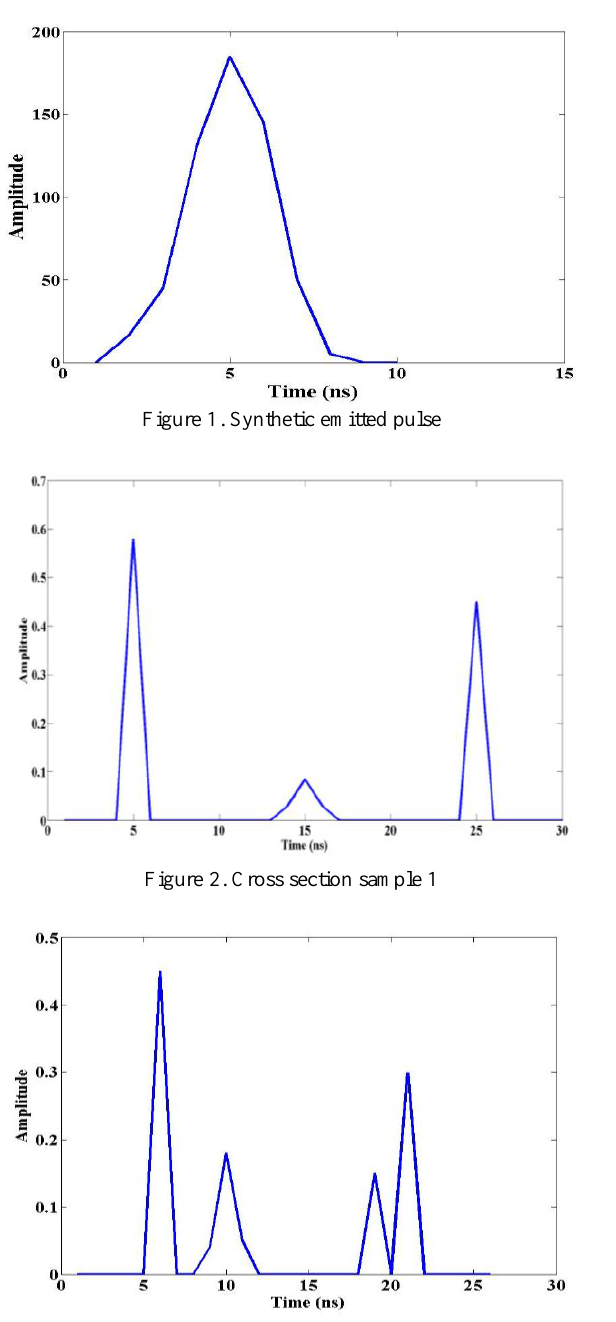
Figure 4. Received waveform and its noisy version (sample 1)